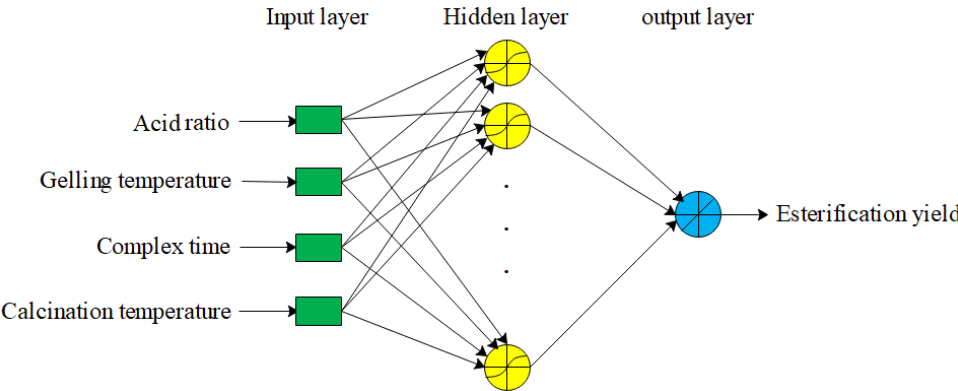
Figure 10. Neural network of MLP for estimation of yield.